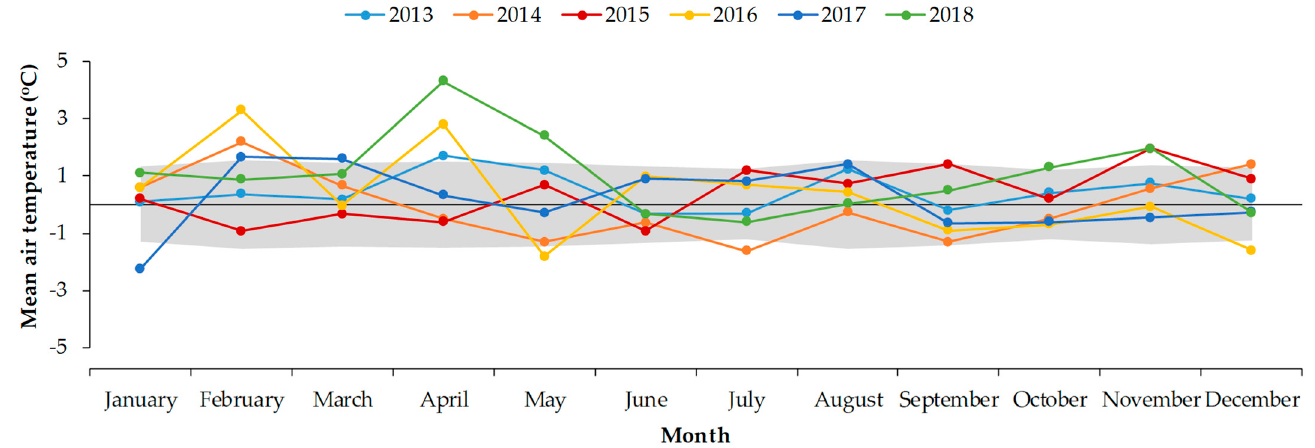
Figure 4. Deviations of mean monthly T av (°C) from the monthly means of the climatic period 1973–2020 (black line in value 0 on the y axis). Shaded areas depict the ± standard deviation (SD) of the same period (confidence interval ±95%).